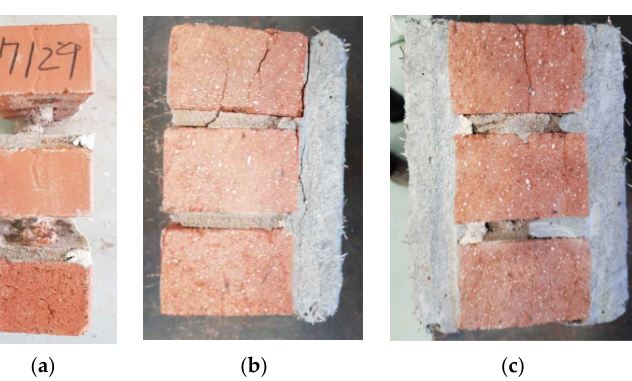
Figure 10. Damage state after termination of bond strength tests: ( a ) B-P; ( b ) SF-30S; ( c ) SF-30B.